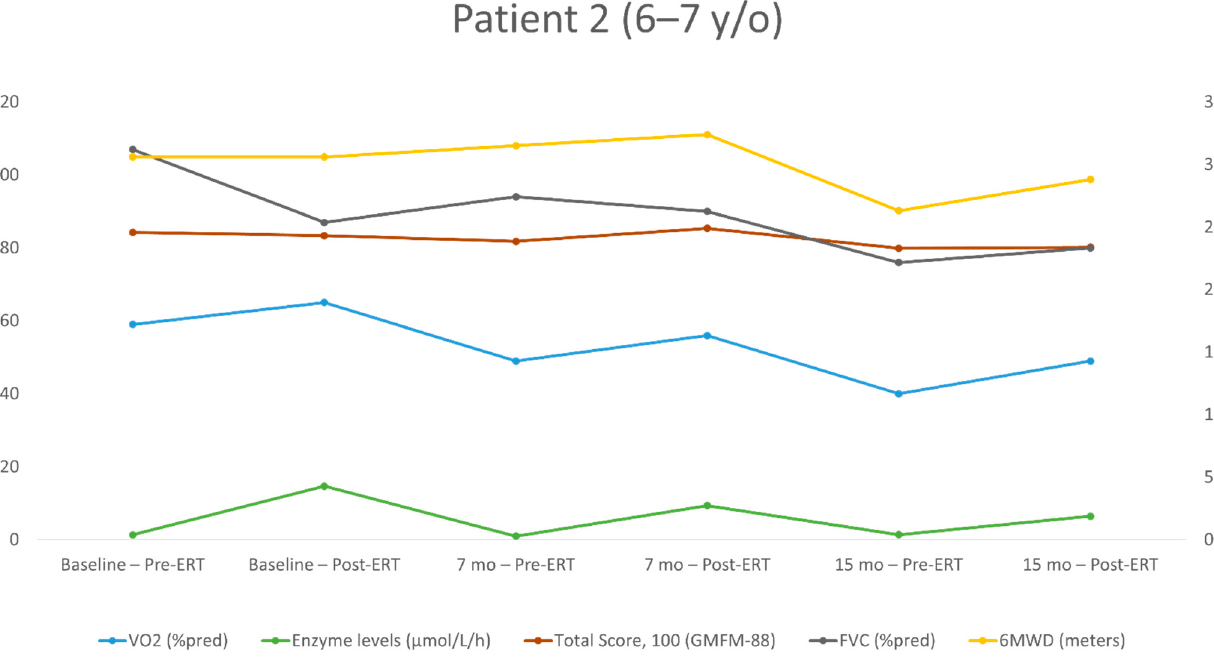
Figure 2. Long-term follow-up of the study parameters (patient 2). y/o = year old; VO 2 = peak oxygen uptake at the peak of exercise; %pred = % of the predicted value; FVC = forced vital capacity; 6MWD = 6-min walking distance.